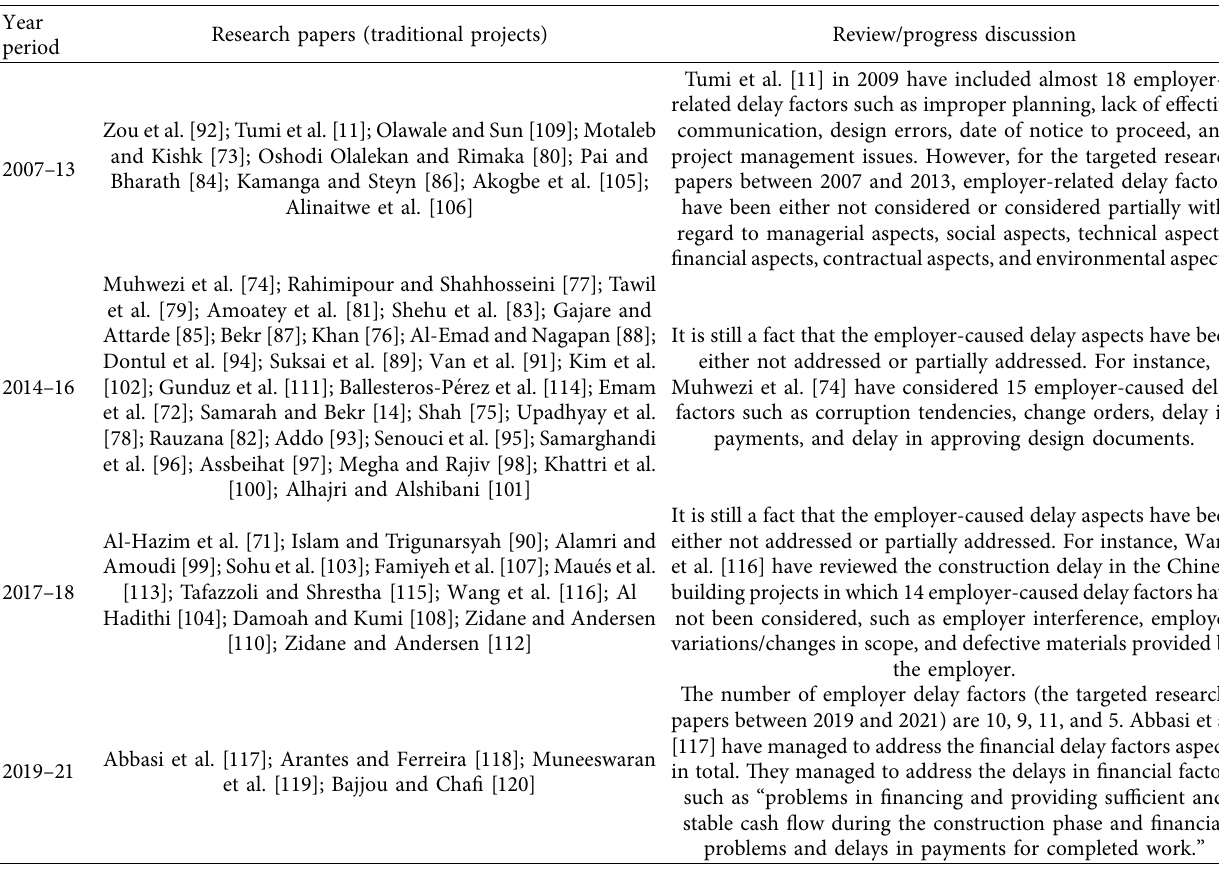
Table 7: A timeline progress review for construction delay aspects addressed in the previous studies for traditional projects.